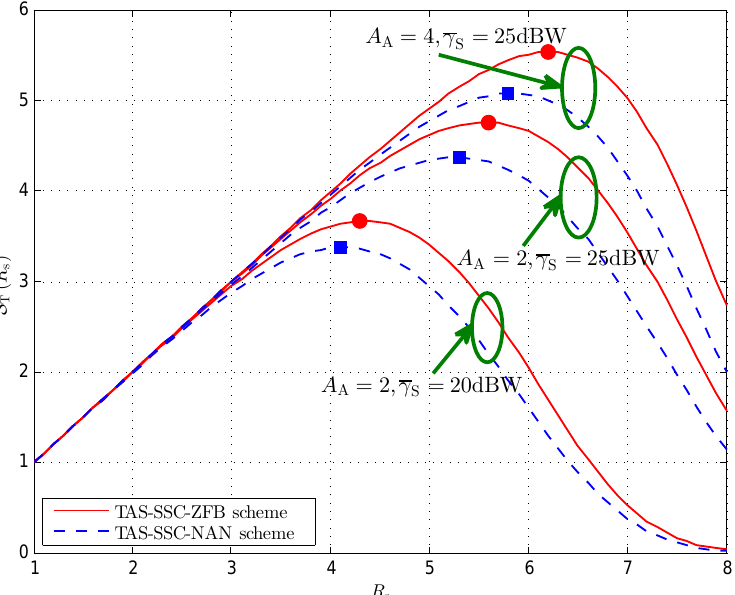
Figure 6. Effective secrecy throughput versus different R s for A J = 3, γ T = 10 dB, N B = 2, γ B / γ E = 10, and φ =